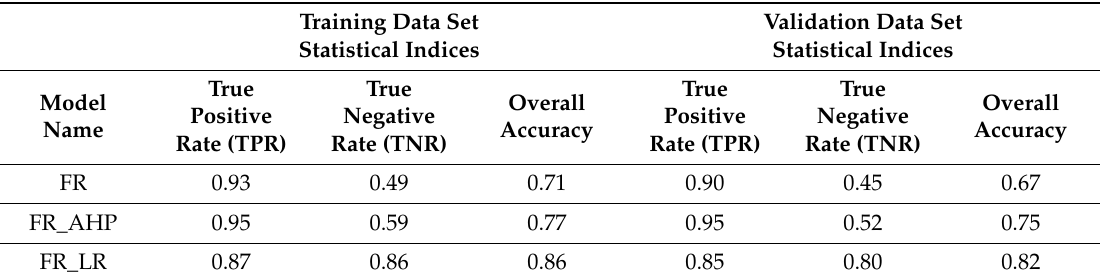
Figure 8. ( a ) Success Rate Curves; ( b ) Prediction Rate Curves. Table 7. Results of the statistical indices of the landslide susceptibility maps.